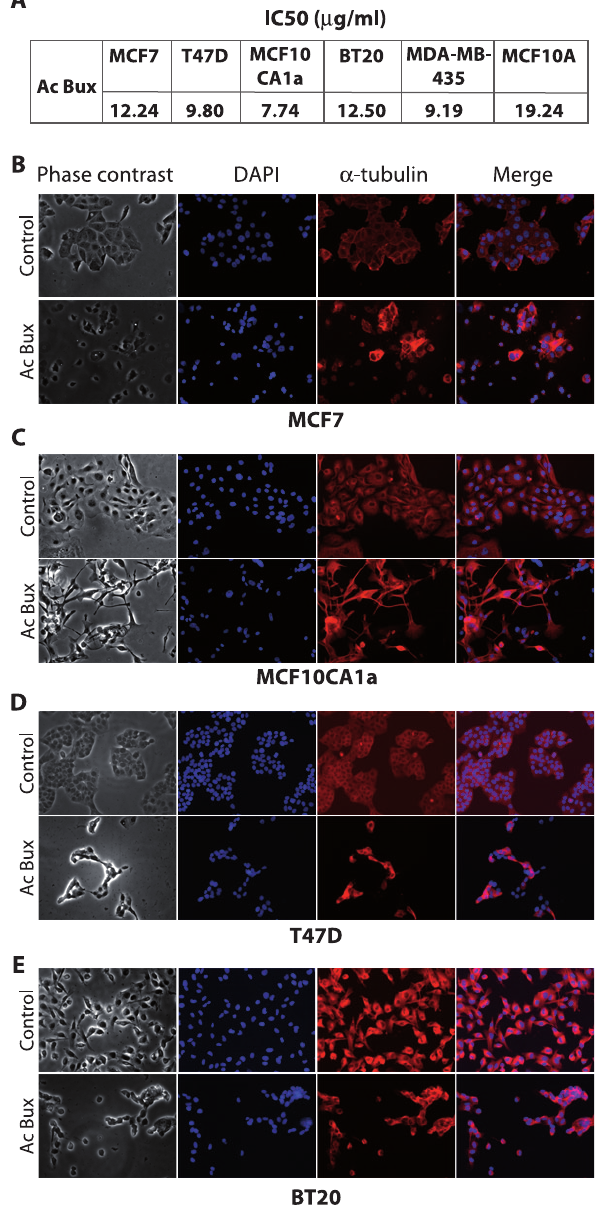
Figure 1. Cytotoxic effects of the acetonic extract of Buxus sempervirens L. towards breast cancer MCF7 and MCF10CA1a cells. A. IC 50 determined by the dose-response curves obtained by the MTT assay. B. C. D. and E. Different cell shapes exhibited by MCF7, MCF10CA1a, T47D, MDA-MB-435 and BT-20, respectively, treated with Buxus extract at their respective IC 50 during 72 h. Left panel: phase contrast images; Right panel: anti- a -tubulin fluorescence staining. Control cells are treated with vehicle DMSO (magnification 6 200). Ac Bux: acetonic Buxus extract.